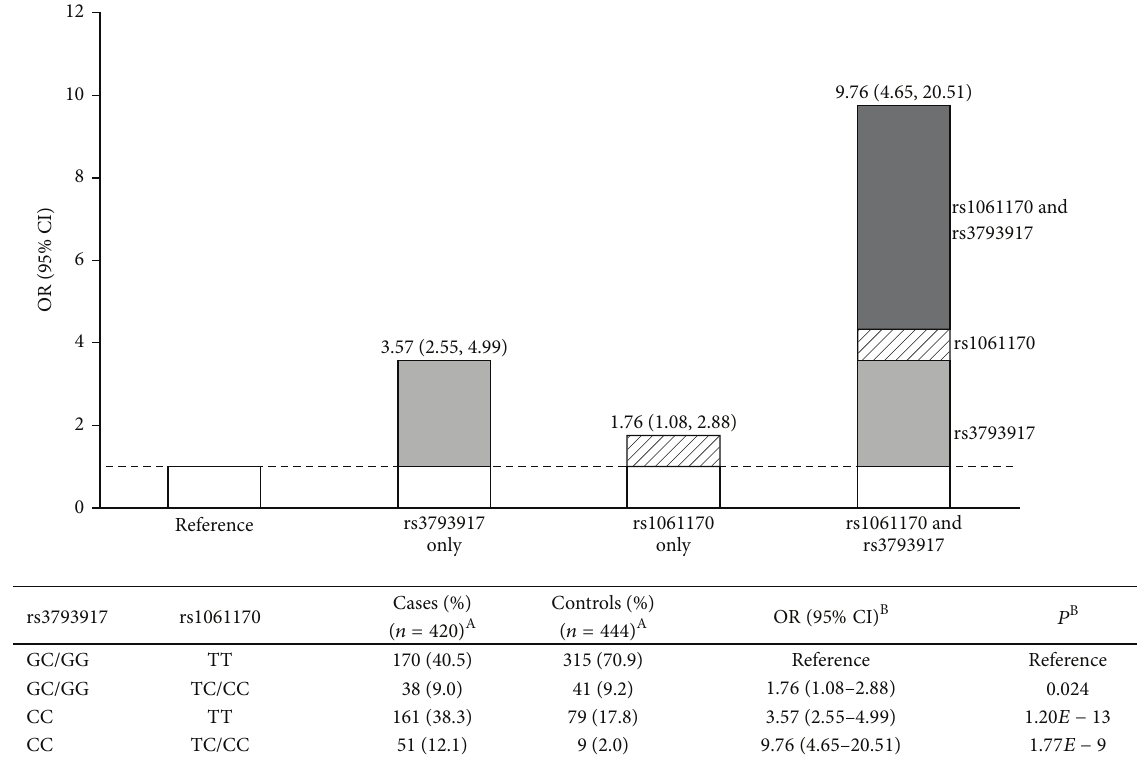
the model included were missing. Figure 2: ORs with contributions from different exposure categories marked according to the departure-from-the-additivity model.